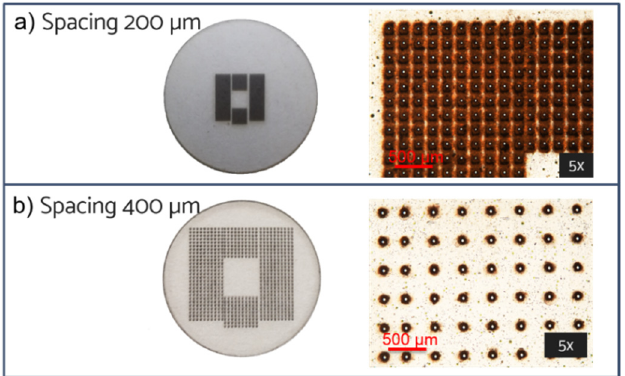
Figure 7. Configuration 3 on CA bottom surface. Distance between micropores ( a ) 200 µm and ( b ) 400 µm. Pore exit dimensions: 18 ± 2 µm. ( b ) 400 µ m. Pore exit dimensions: 18 ± 2 µ